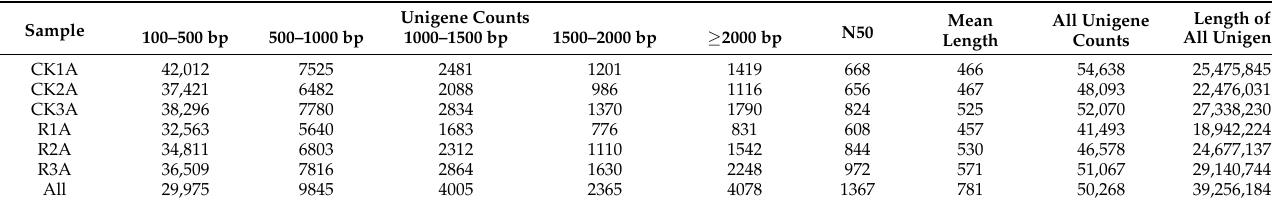
Table 1. Statistics of assembled